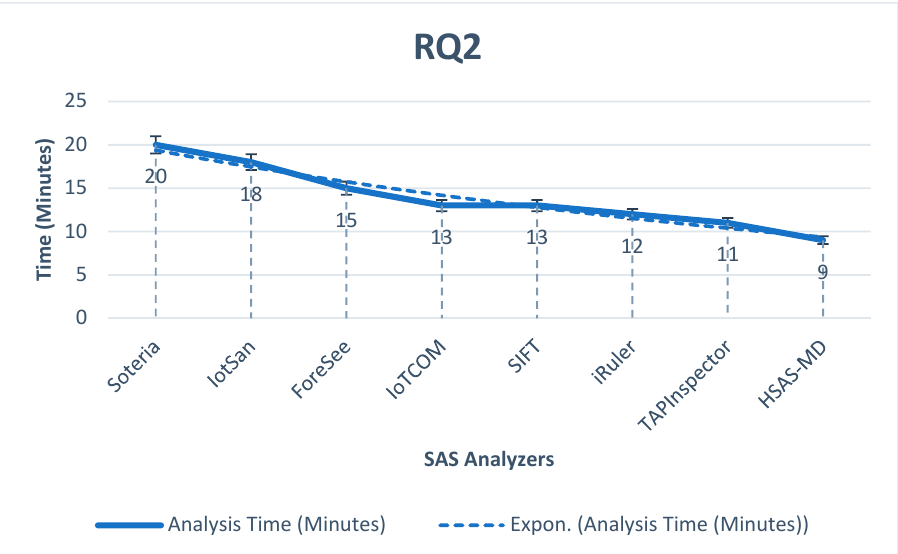
Figure 13. The comparison of the proposed HSAS-MD analyzer with other related analyzers based on ACC, PRC, RCL, and F-MS.